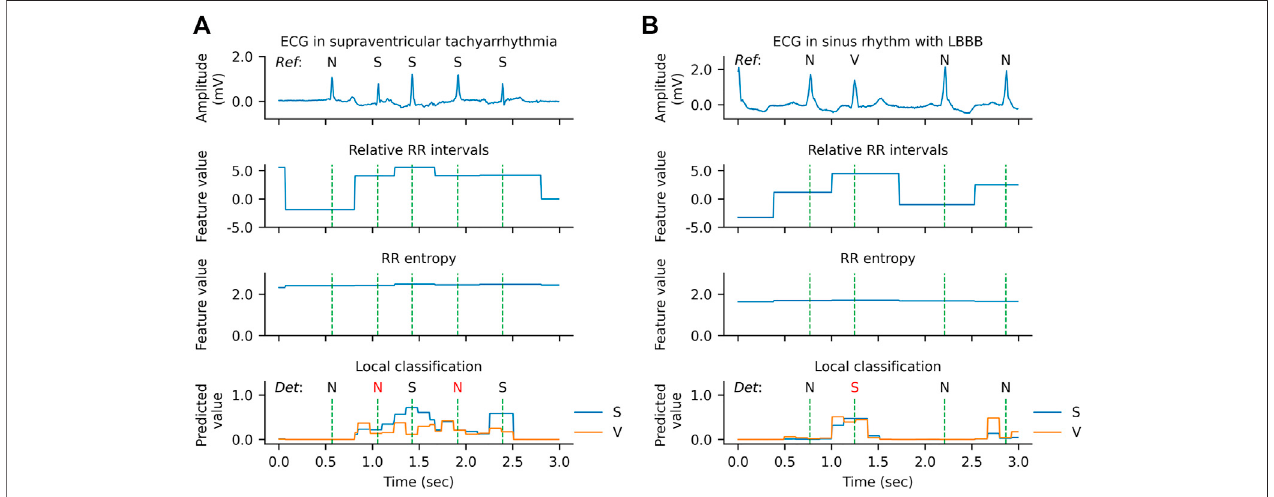
FIGURE 9 | Qualitative results of error predictions. (A) An example of misclassifying supraventricular ectopic beats (S) as normal or bundle branch block beats (N) during supraventricular tachyarrhythmia. (B) An example of misclassifying a ventricular ectopic beat (V) as an S during left bundle branch block (LBBB).